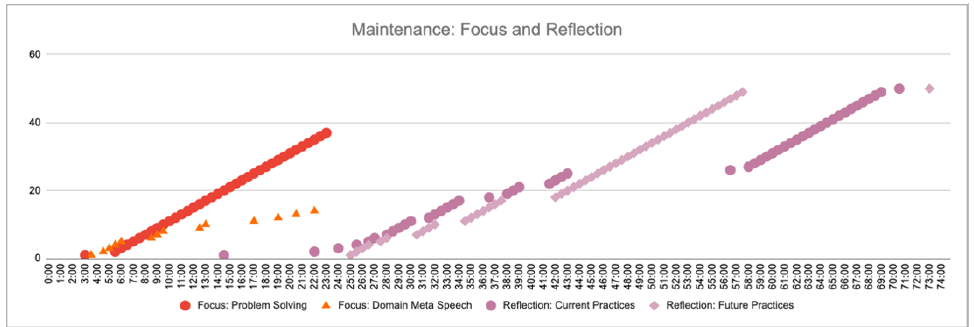
Figure 7. Cumulative number of conversation segments between focus and planning reflection, suggesting 3 different